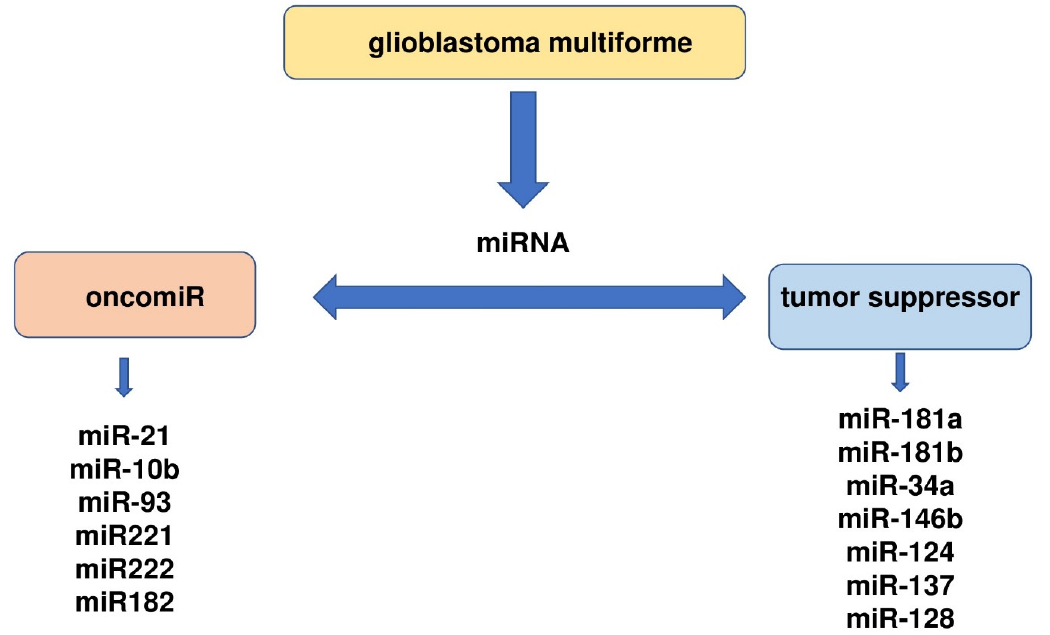
Figure 2. Oncogenic miRNAs and tumor suppressor miRNAs in glioblastoma multiforme.